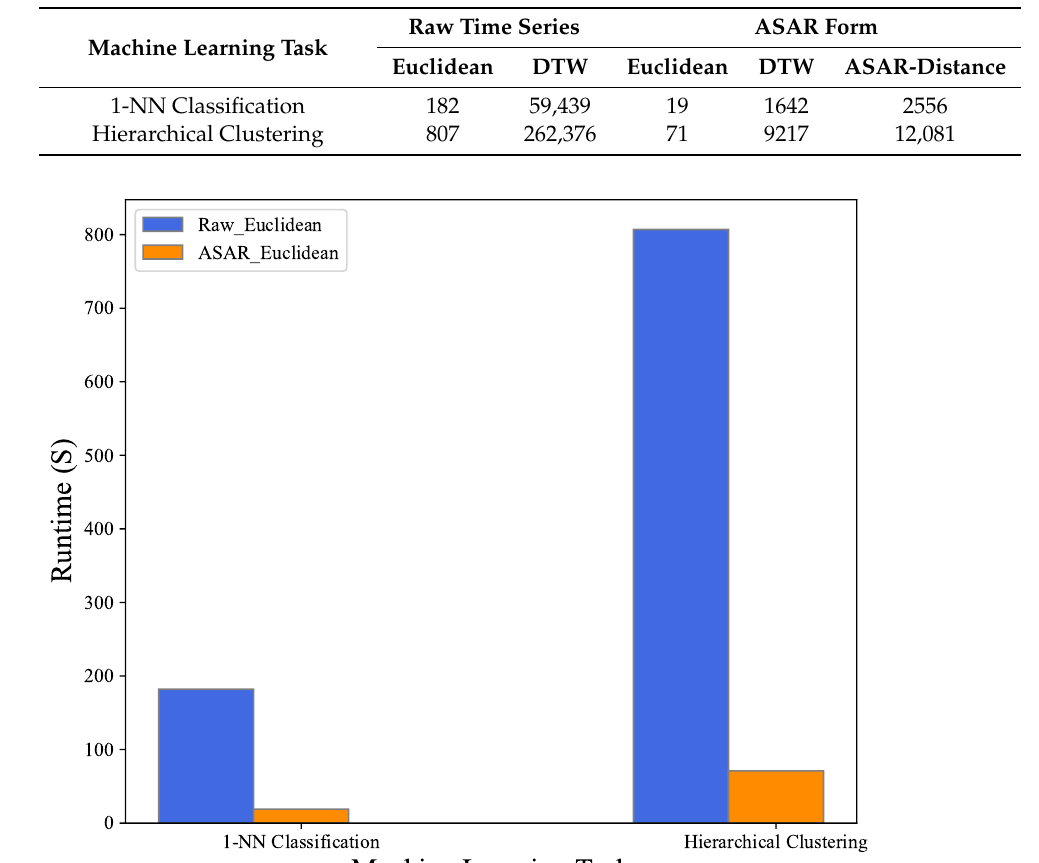
Table 4. Summary of classification and clustering runtimes (in seconds).